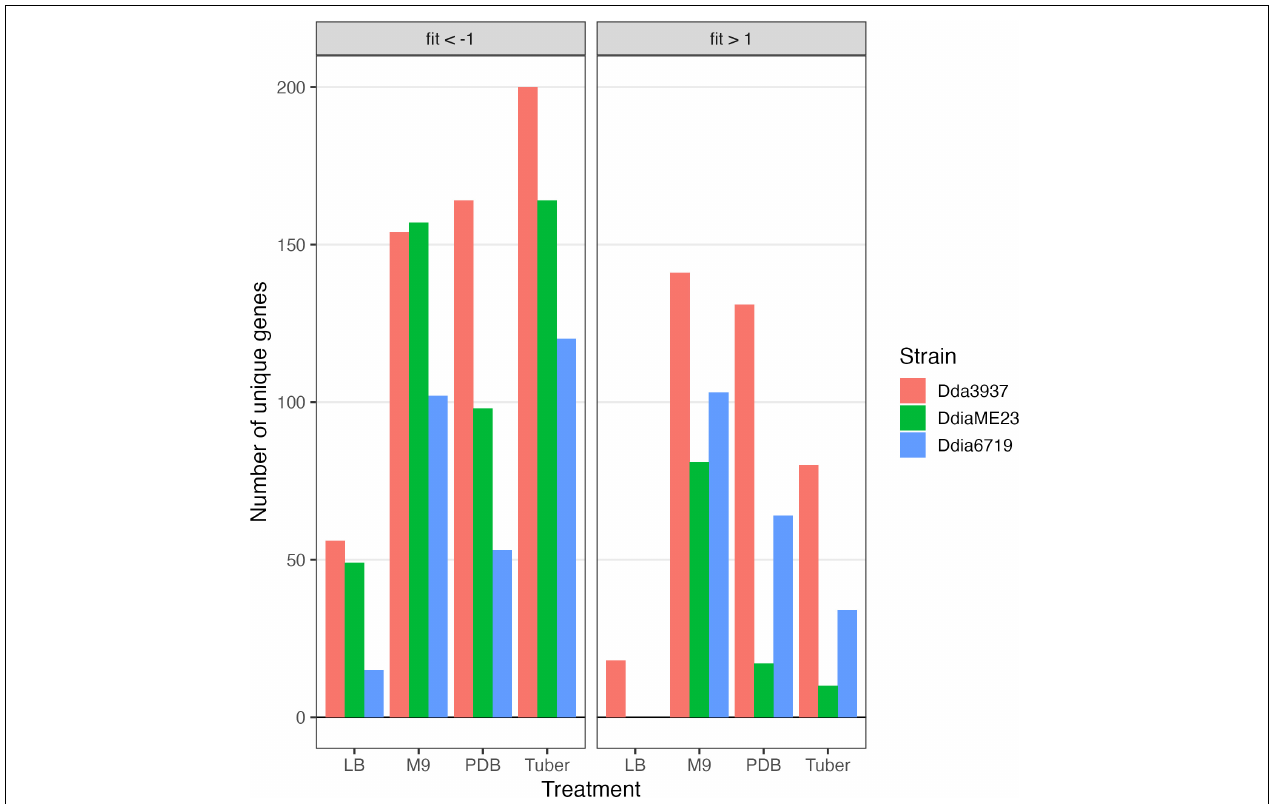
FIGURE 2 | Number of unique genes for each condition with fitness values of < –1 or > 1, and absolute t-like test statistic > 4 in at least one replicate